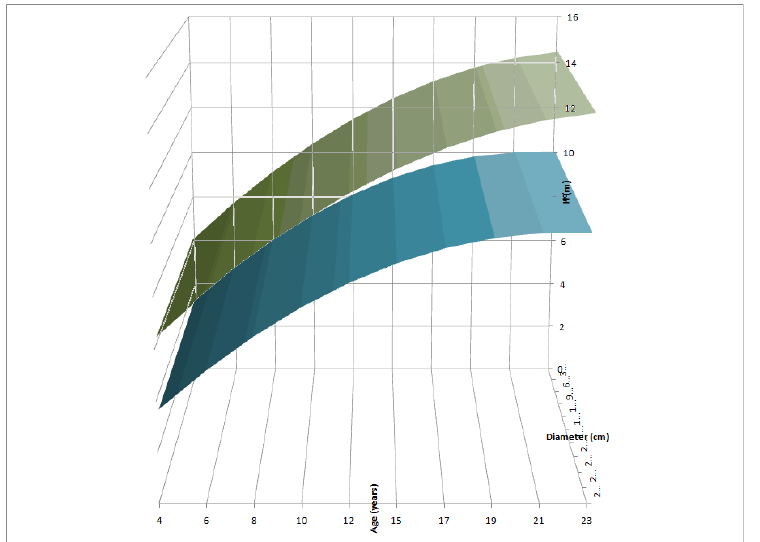
Figure 4. Total height estimation (upper surface) and bole height estimation (lower surface), with estimation surfaces developed from the selected total height – age and bole height – age models.